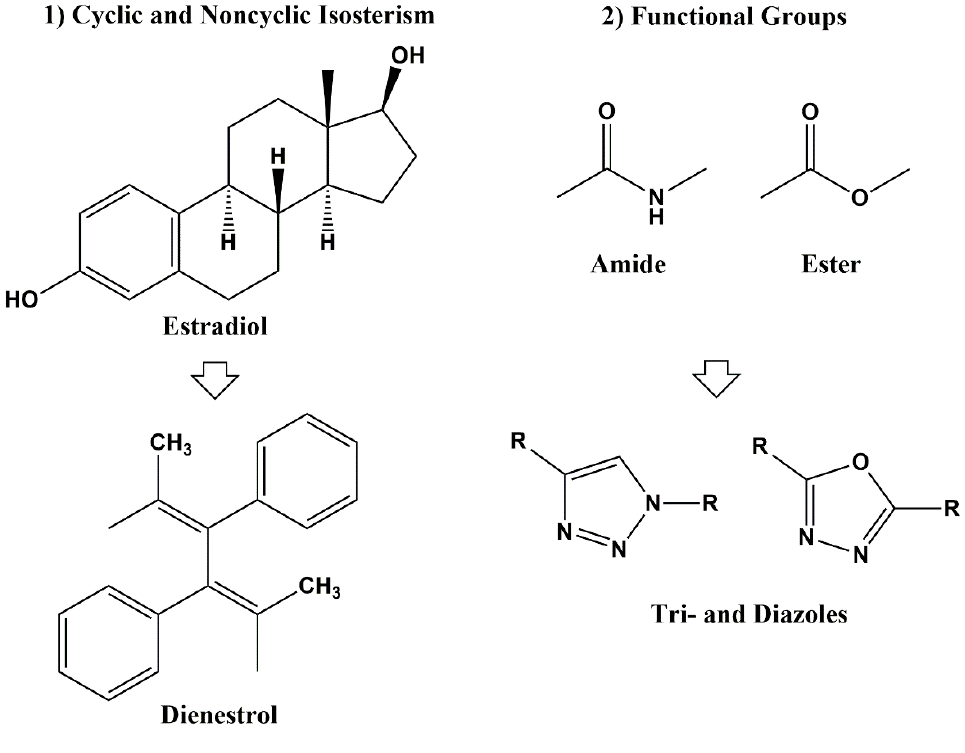
Figure 1. Non ‐ Classical Bioisosterism. Figure 1. Non-Classical